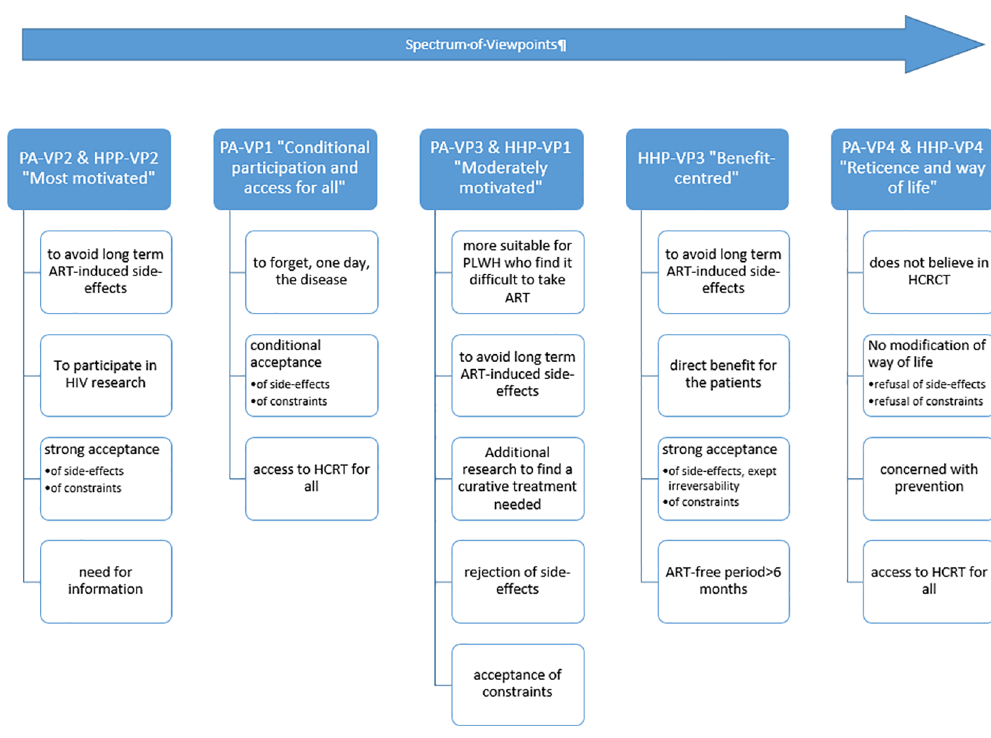
Fig 2. Summarized description of